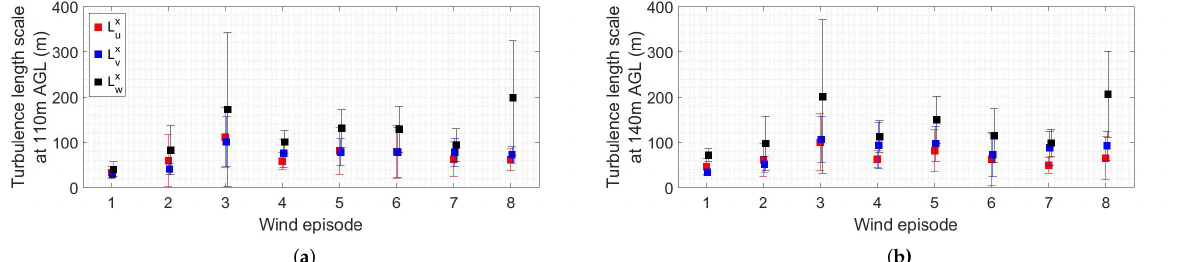
Figure 14. Mean values of along-wind turbulence length scales, obtained from Doppler wind lidar measurements at 110m AGL ( a ) and 140m AGL ( b ) for all eight wind episodes.